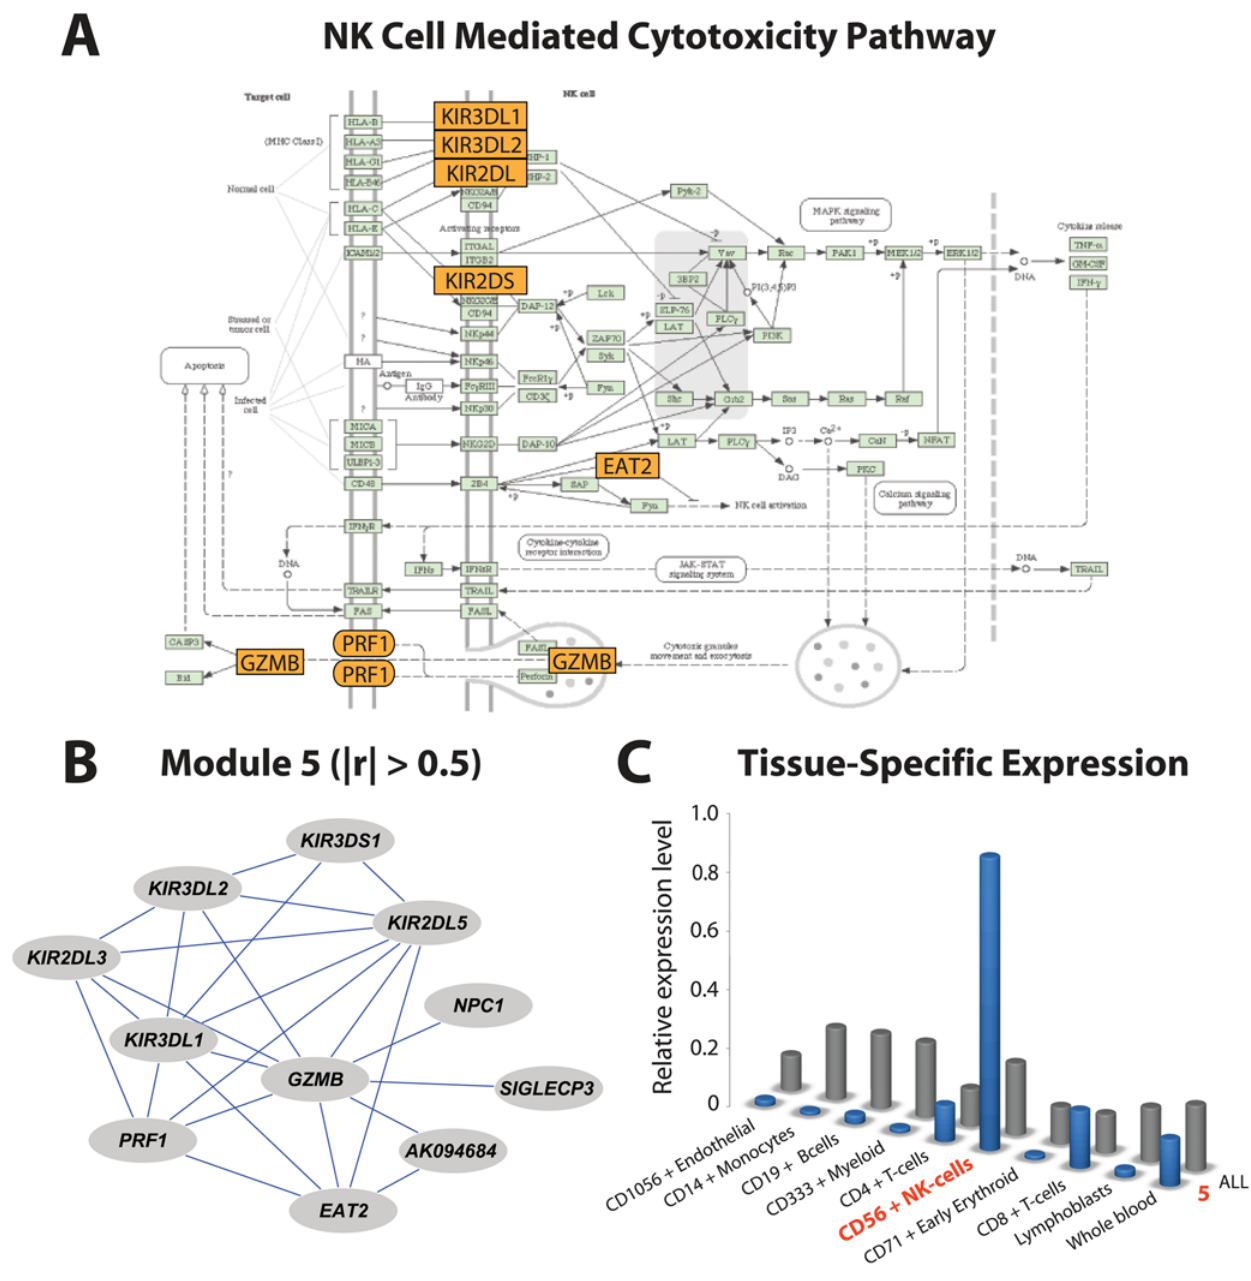
Figure 7. Illustration of module-specific enrichment of pathways and tissues. (A) Representation of the NK cell mediated cytotoxicity KEGG pathway. Genes in Module 5 associated with HDL-C variation are colored orange. (B) Relevance network representation of Module 5 after enforcing an absolute correlation threshold of 0.5. (C) Bar graphs of cell-specific expression patterns restricted to derivatives of whole blood. Grey bars indicate relative cell-specific expression levels across all 673 genes associated with HDL-C. Blue bars consider only the genes in Module